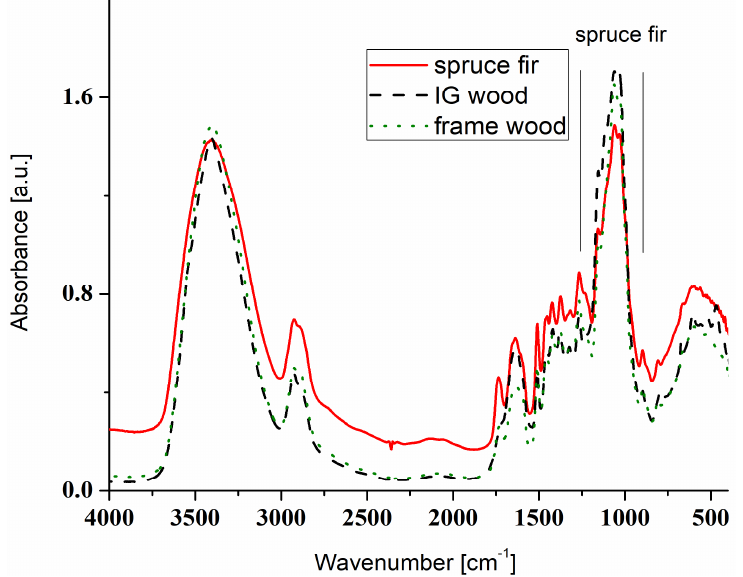
Figure 10. Imperial gates’ wood- and frame wood FTIR spectra (as compared to the spruce fir one).